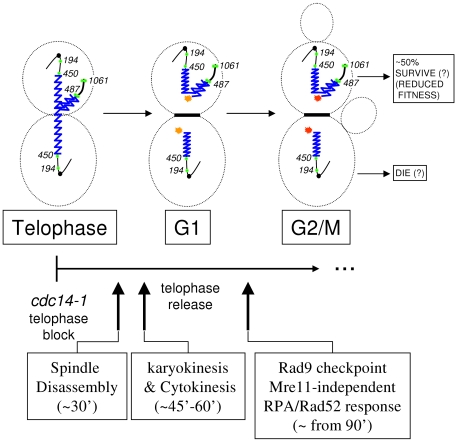
Model of how the cell cycle progresses after the presence of the cXIIr bridge.Location of tetOs is shown as green dots; rDNA is depicted as a serrated blue line; and thicker lines indicate non-resolved sister chromatids. Stars indicate the expected “one-ended” double strand break (orange star means that the break does not elicit a strong DNA damage response; whereas red star means it does). Main cell cycle events described in this article are indicated in a time line underneath. The likely long-term fate of each daughter cell (as deduced from Figure 8) is also indicated.